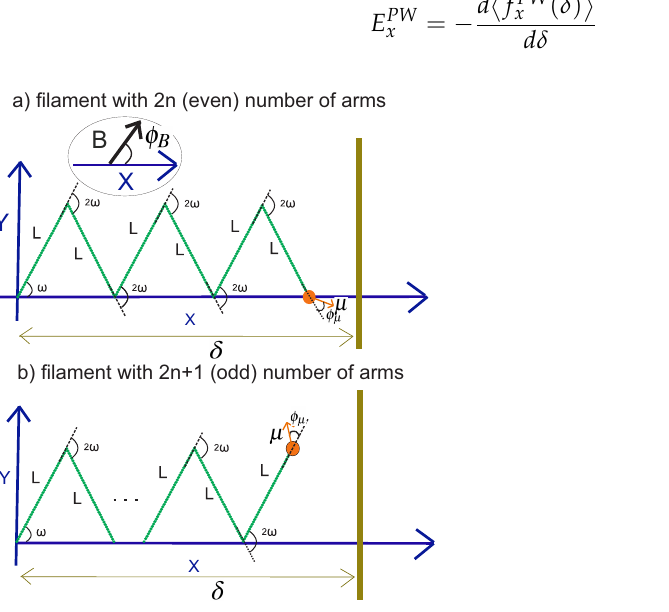
Figure 15. Panel ( a ): The endpoint of the kinked filament with an even number of arms is attached to the magnetic bead and is confined by a rigid impenetrable wall in the x -direction. Panel ( b ): The similar confined system with an odd number of